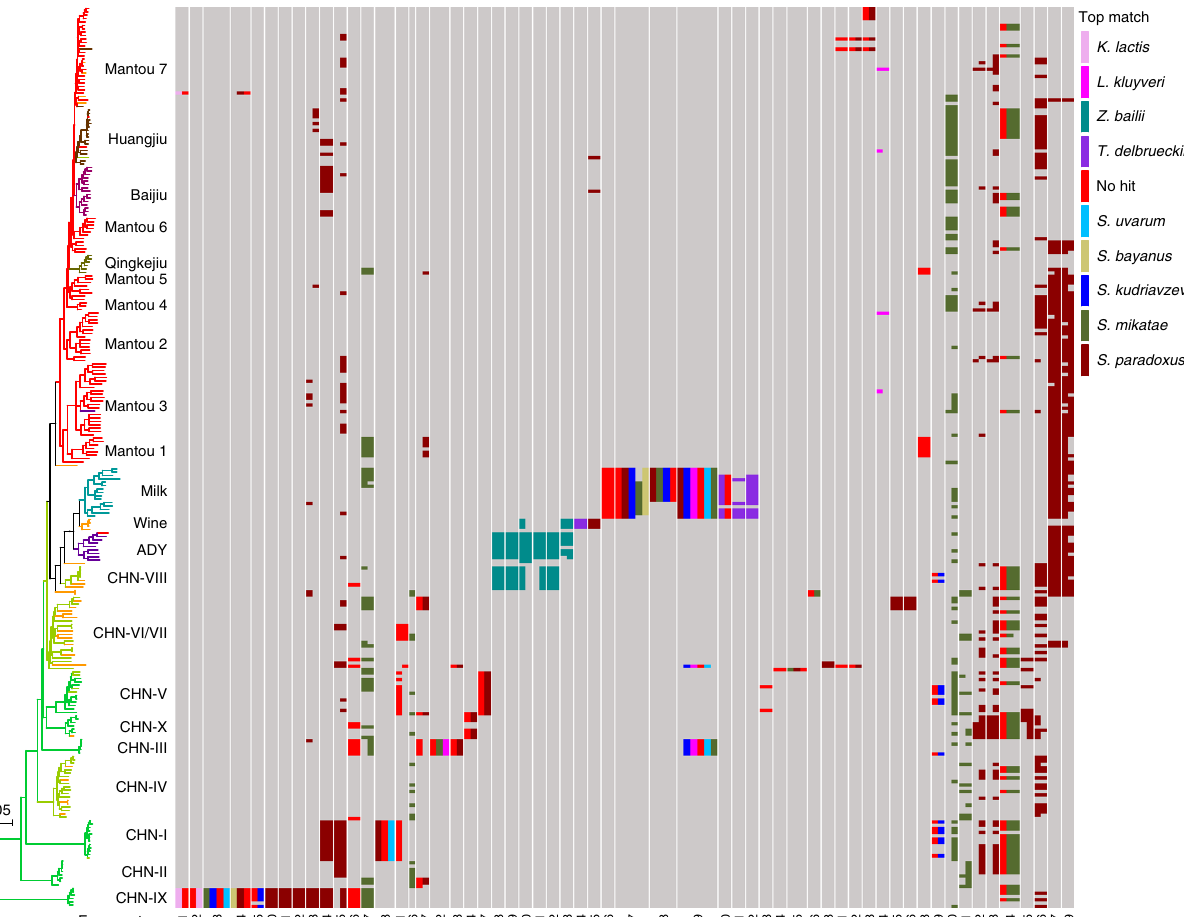
Fig. 4 Selected introgression and horizontal gene transfer (HGT) events in wild and domesticated isolates of S. cerevisiae . Isolates are represented by terminal branches in the phylogenetic tree constructed from the maximum likelihood analysis on genome wide SNPs and are colored according to their ecological origin as shown in Fig. 1. The fragments (numbered at the bottom) with top matches from species other than S. cerevisiae are shown, which are selected from the 79 possible introgression and HGT fragments (Supplementary Data 7) detected in the 266 isolates of S. cerevisiae included in the tree. Top matches or putative sources of the alien fragments are shown on the upper right based on sequence identities given in Supplementary Data